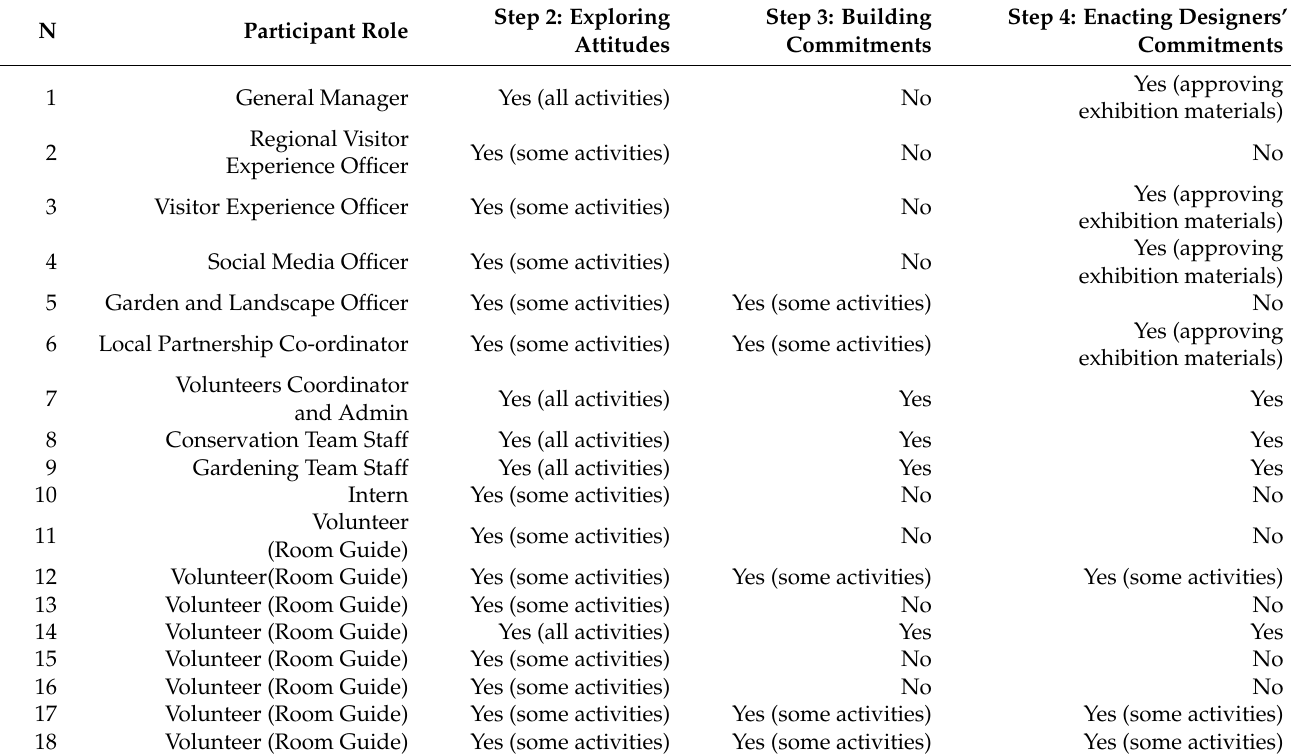
Table A1. Table of